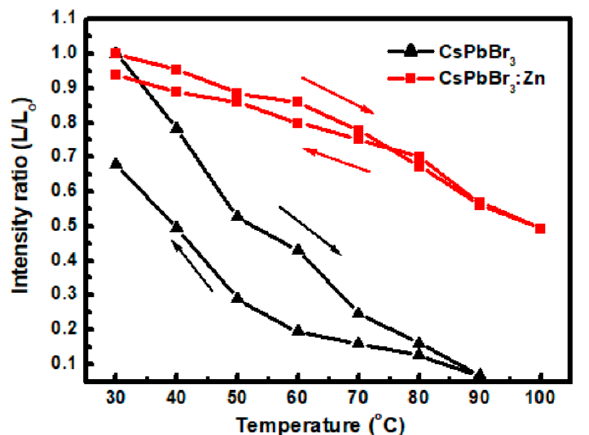
Figure 7. Variation of PL intensity ratio of NCs during the heating/cooling cycles. The excitation source is a UV-LED lamp.